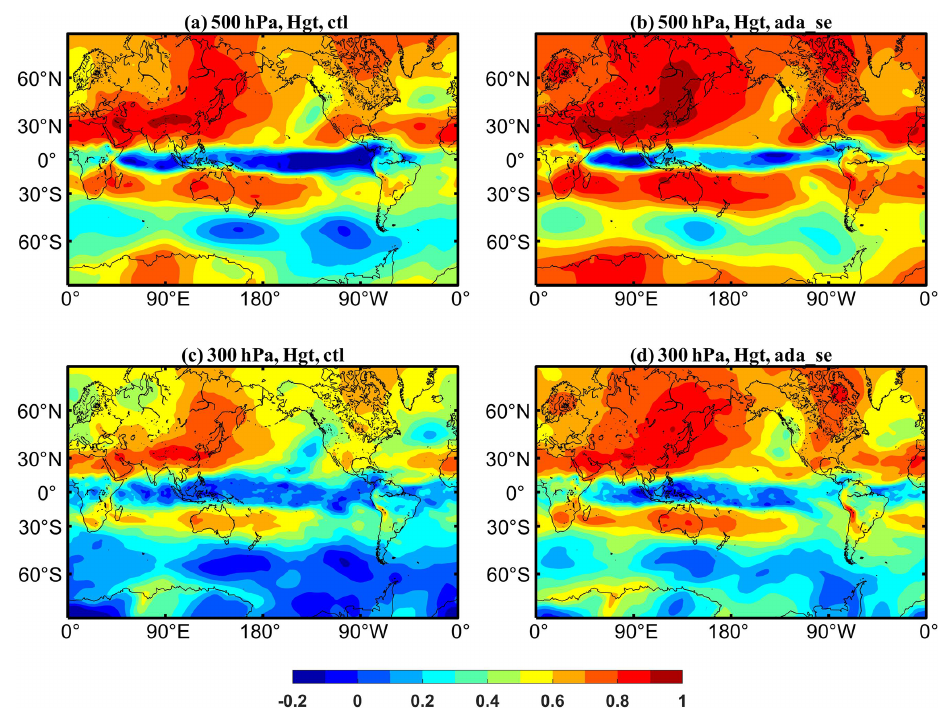
Figure 8. Map of the local anomaly correlation between four-times-daily anomalies of 500hPa (a, b) and 300hPa (c, d) geopotential (a, c) between ctl and truth and (b, d) between ada_se and truth. Anomalies are computed separately for each dataset with respect to the mean annual cycle of the period shown.